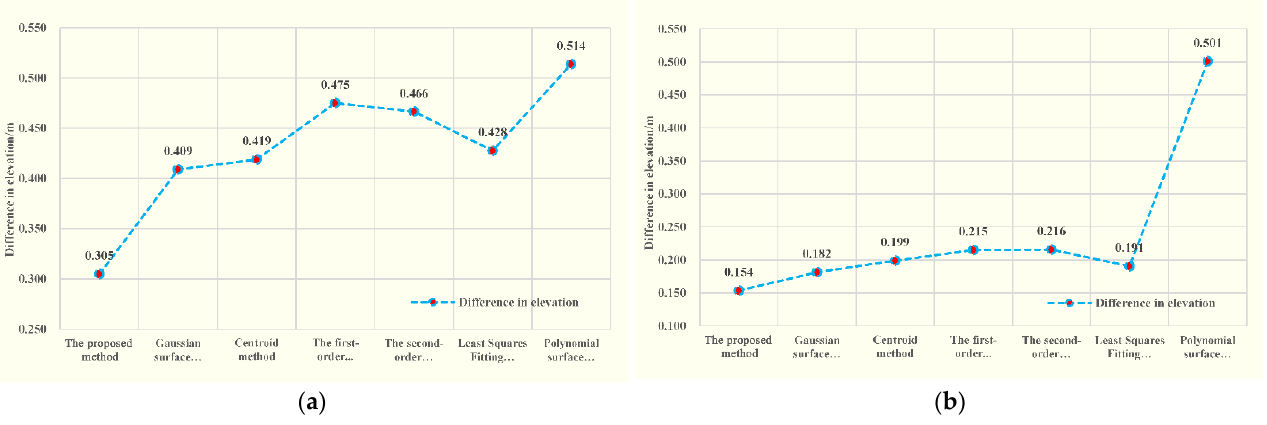
Figure 18. Elevation accuracy of laser footprints positioned with calibration parameters obtained with different methods for beam 1 ( a ) and beam 2 ( b ) on gentle slopes.